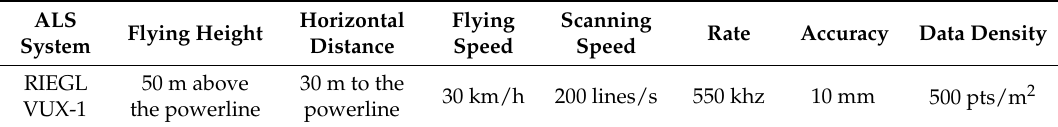
Table 2. Details about the data acquisition.